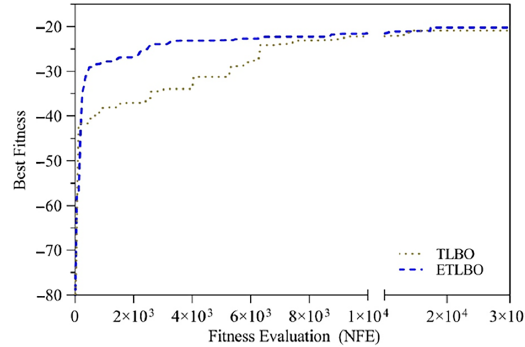
Figure 9. Convergence comparison of ETLBO vs. TLBO for the 582-bar truss